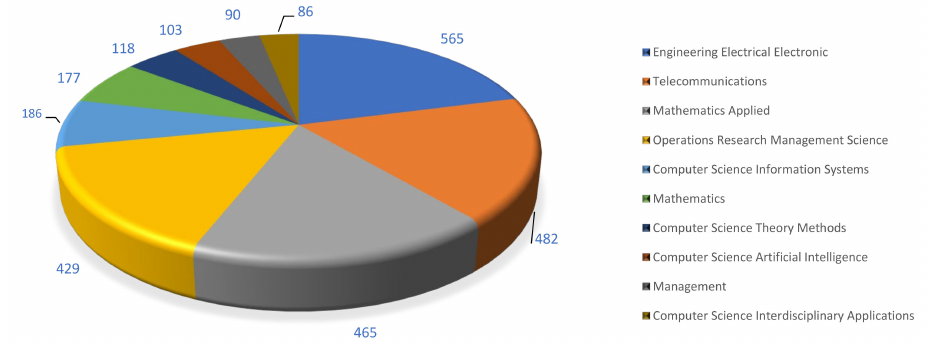
Figure 4. Top 10 FP categories.